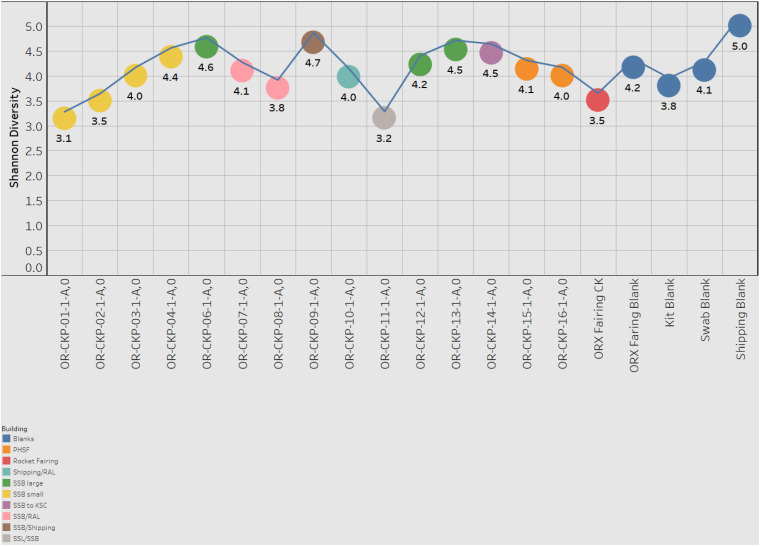
Shannon index for each sample. Samples are colored according to the building in which the witness foil was exposed.